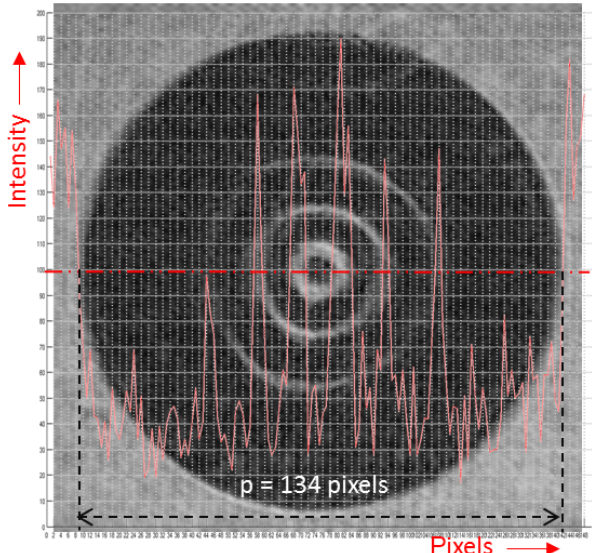
Figure 5. The intensity profile of the row corresponding to the di- ameter of the